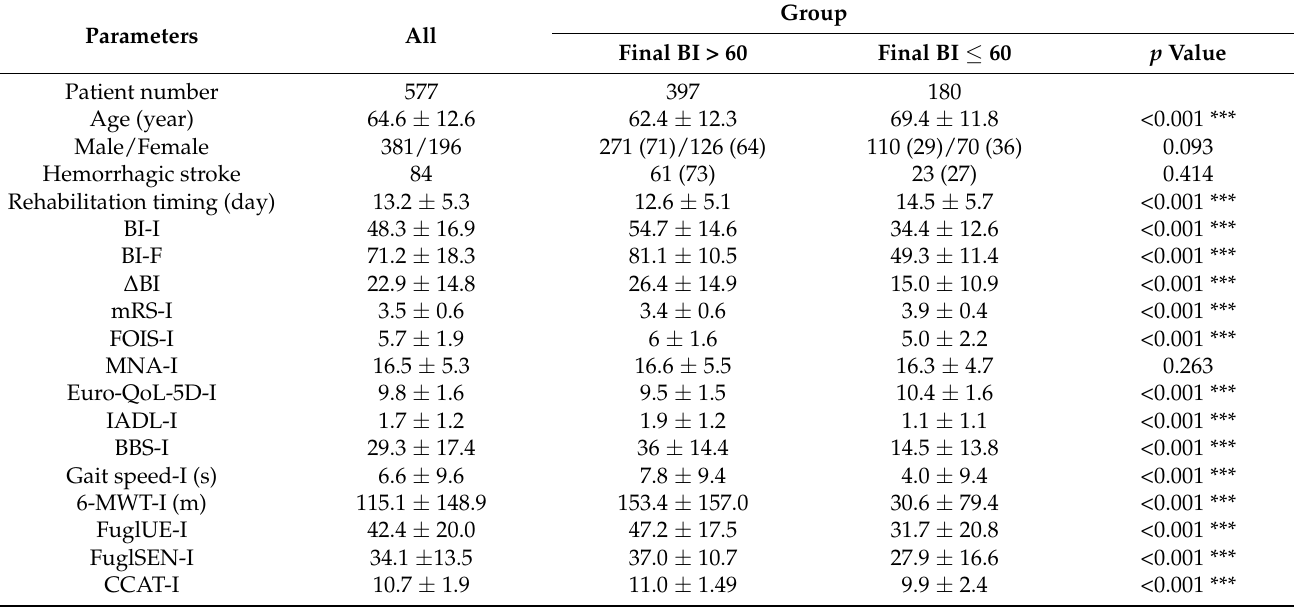
Table 1. Patients’ demographic